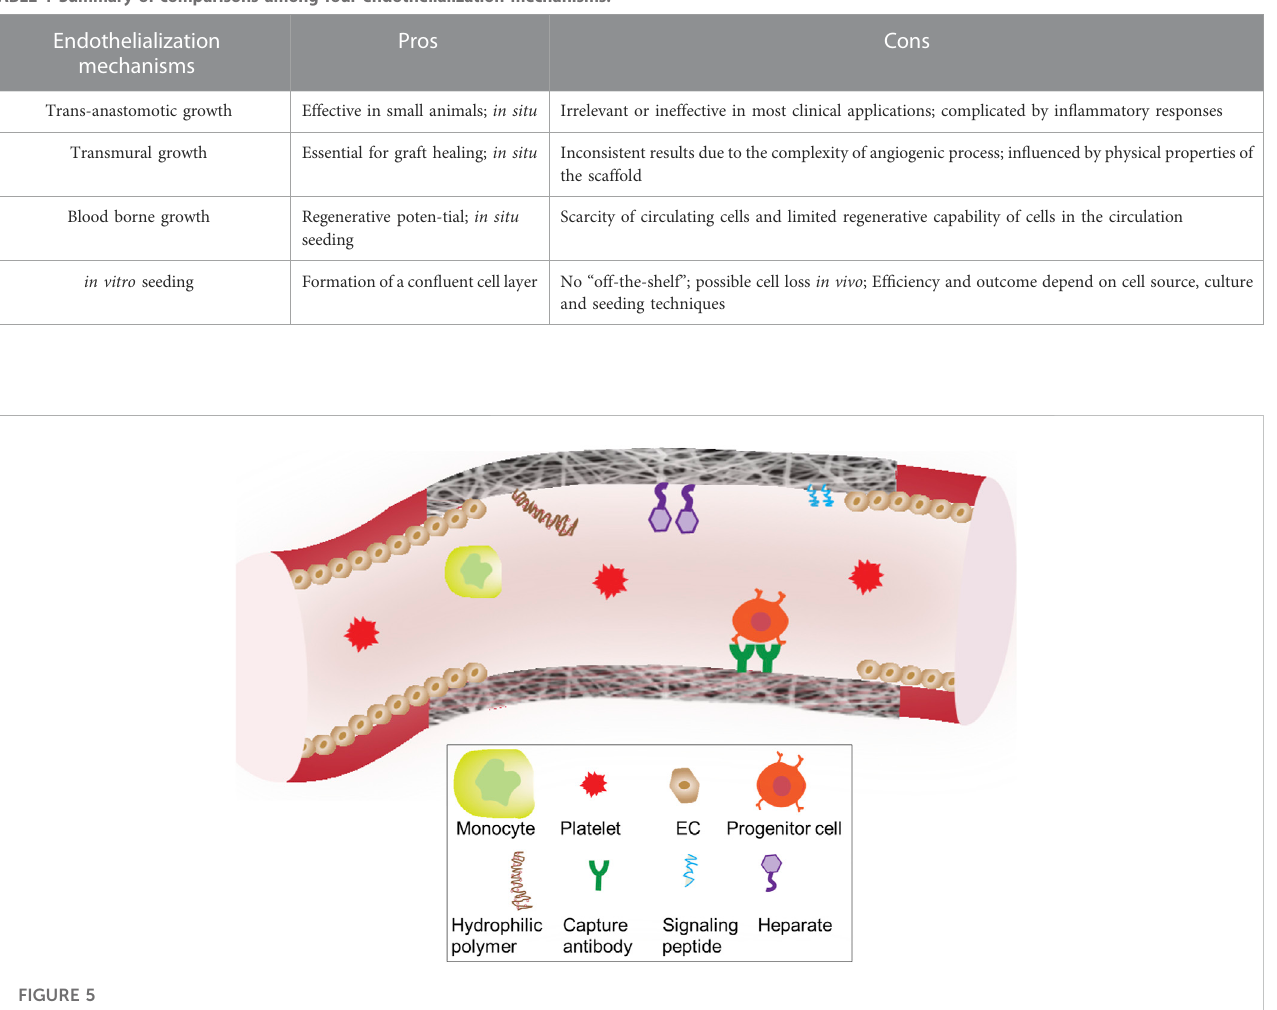
Frontiers in Bioengineering and